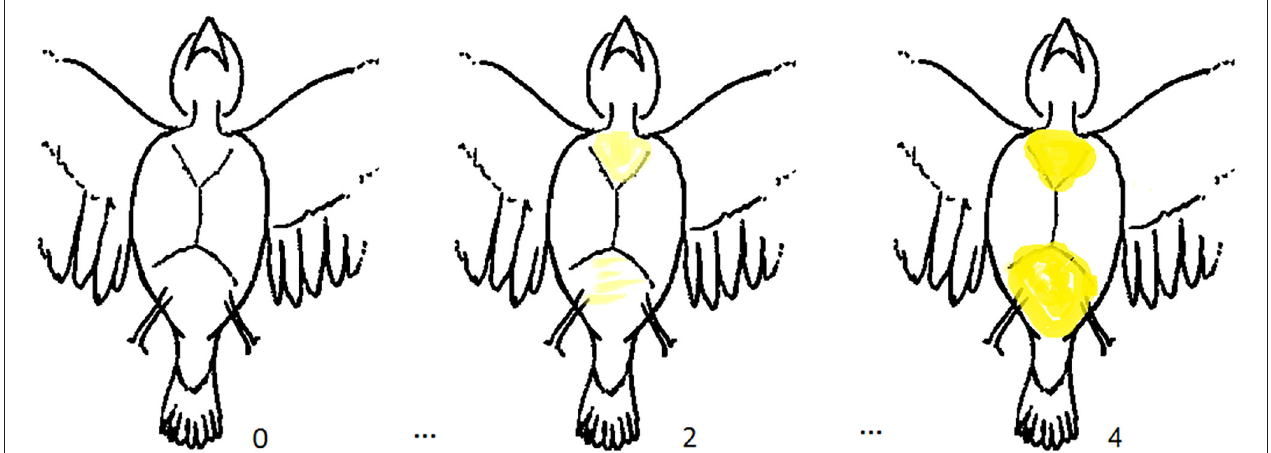
FIGURE 3 | Outlined examples of the fat score.